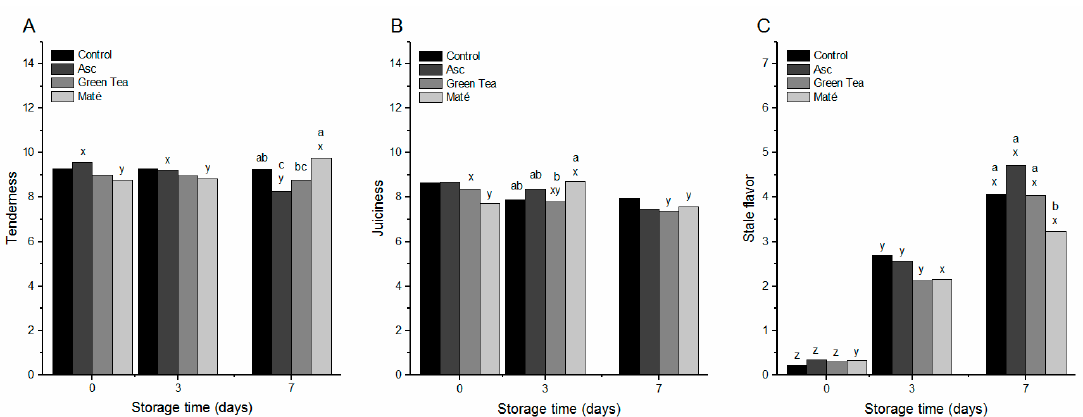
Figure 1. Tenderness ( A ); juiciness ( B ); and stale flavor ( C ) of pork chops injected with salt brine (Control), or brine added 225 ppm ascorbate (Asc), green tea (~25 ppm gallic acid equivalents (GAE)), or maté extract (~25 ppm GAE) and chill stored in high-oxygen modified atmosphere packaging (MAP) for 0, 3 or 7 as evaluated by a trained sensory panel. LSMeans with different letters (a–c) differ significantly ( p < 0.05) between injection brines within the same day of storage, and LSMeans with different letters (x–z) differ significantly ( p < 0.05) between days of storage within the same injection brine.